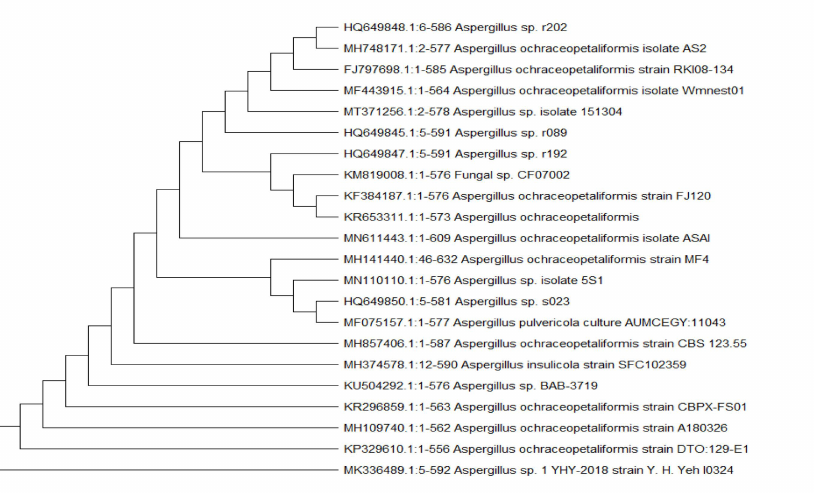
Figure 2. Neighbor-joining phylogenetic tree of the fungal strain ASAI based on 18S rRNA gene sequences, showing its close relationship to Aspergillus